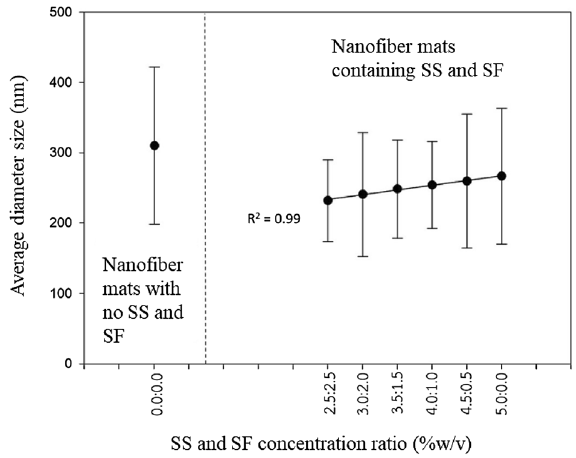
Figure 1. Average diameter size of the fabricated nanofibers with different SS/SF concentration